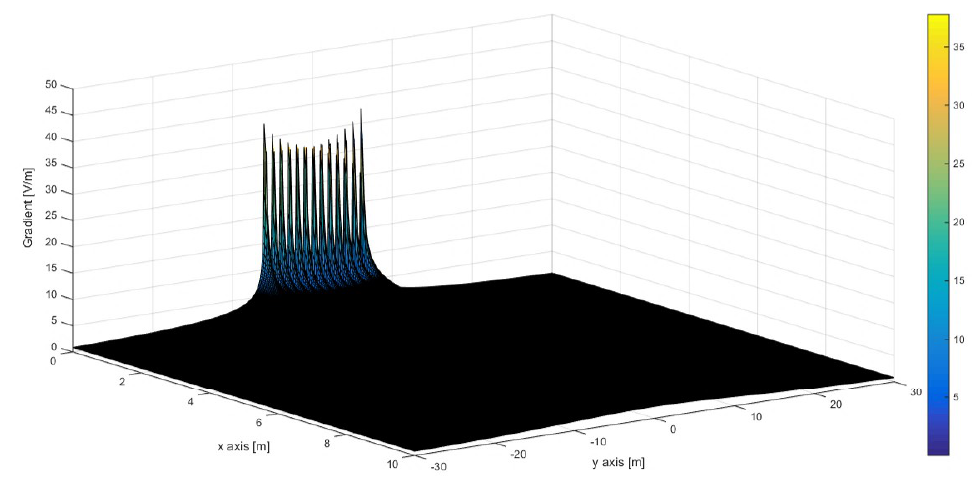
Figure 20. Electric field strength for method “C”, of linear current source, for a linear frame of 13 electrodes, with D el = 1.0m for the area of Korakia ( ρ S = ∞ , without dam, L = 1.1815 m,